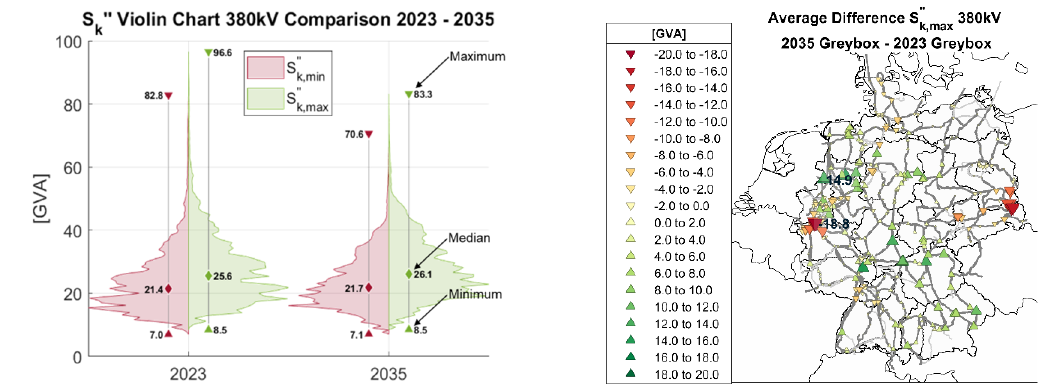
Figure 12. Distribution of (cid:1845) (cid:3038),(cid:3040)(cid:3028)(cid:3051)(cid:4593)(cid:4593) and (cid:1845) (cid:3038),(cid:3040)(cid:3036)(cid:3041)(cid:4593)(cid:4593) for 2023 and 2035 ( left ) and average differences of (cid:1845) (cid:3038),(cid:3040)(cid:3028)(cid:3051)(cid:4593)(cid:4593) between 2035 and 2023 in Germany ( right ).